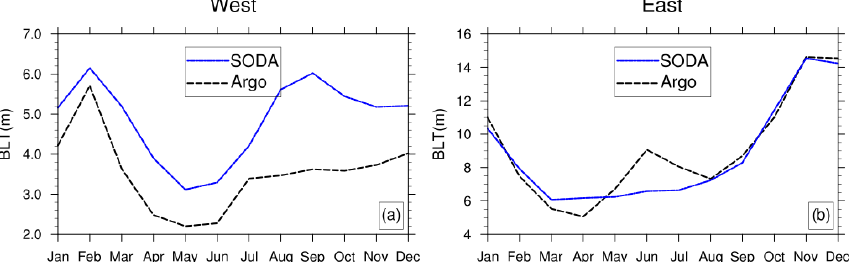
Figure 2. Seasonal cycle of the region-averaged BLT for SODA and Argo: (a) the western TIO (12 ◦ S–5 ◦ N, 55–75 ◦ E) and (b) the eastern TIO (12 ◦ S–5 ◦ N, 85–100 ◦ E).